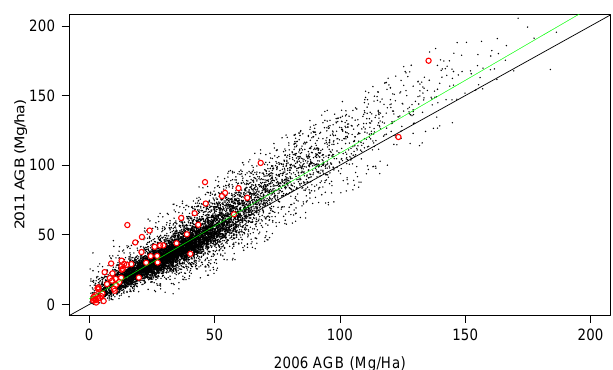
Figure 3. Scatterplot of above-ground biomass (AGB) estimates for 2006 and 2011: lidar (black dots), Spanish Forest Inventory (red bordered circles), with one-to-one line (black) and fitted model